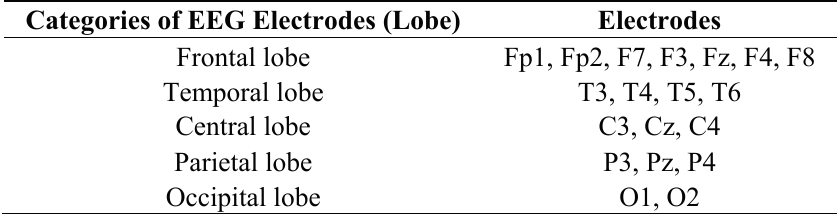
Table 2. Categories of EEG data according to each lobe for